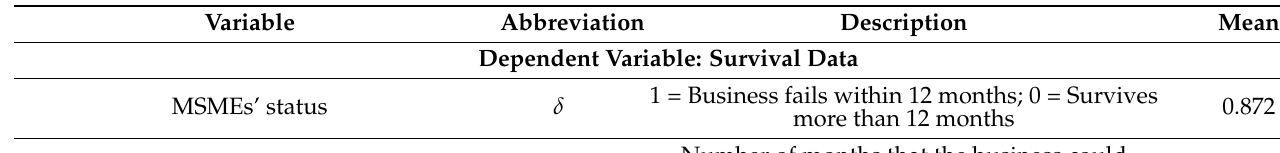
Table 2. Variable descriptions and descriptive